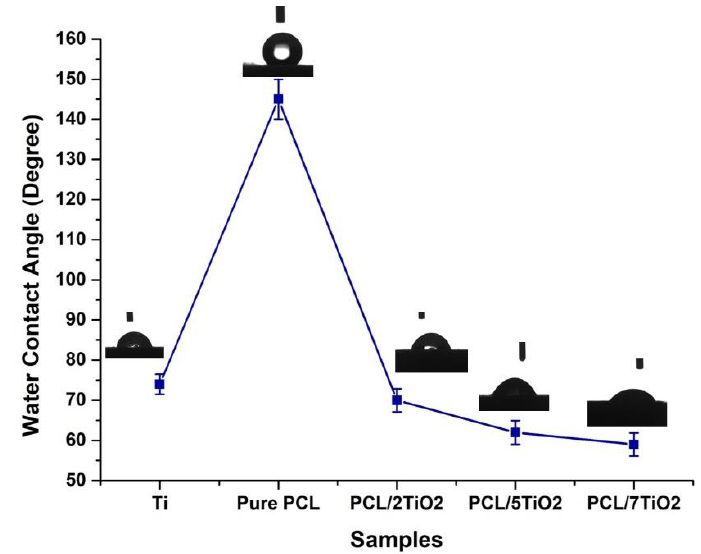
Figure 3. Water contact measurements on various surfaces obtained as a function of TiO 2 wt % with distinctive water droplet images after 5 s from droplet.